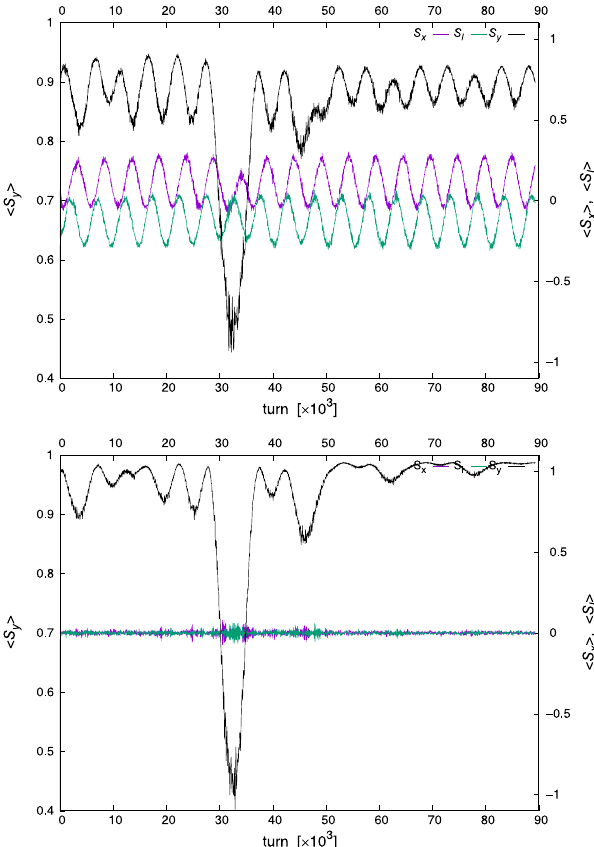
FIG. 23. Turn-by-turn h S y i (left axis), h S x i and h S l i (right axis), an average over 1000 particles, during the crossing of the intrinsic resonance G γ ¼ 393 þ ν y , at a rate of 200 kV = turn. Observation point is IP6. All initial spins are vertical, whereas ⃗ n 0 is not. Top: a case of 90% 9 o ’ clock snake (two helices) and 91% 3 o ’ clock snake (four helices); nonzero hh S x ii and hh S l ii turn averages reflect ⃗ n 0 tilt. Bottom: both snakes are full snakes